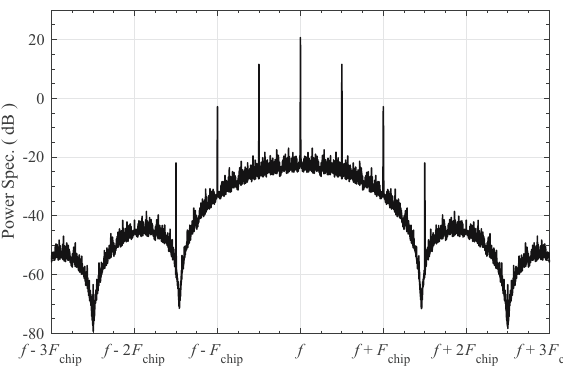
Figure 1: Power spectrum of the signal phase - modulated by the T4B